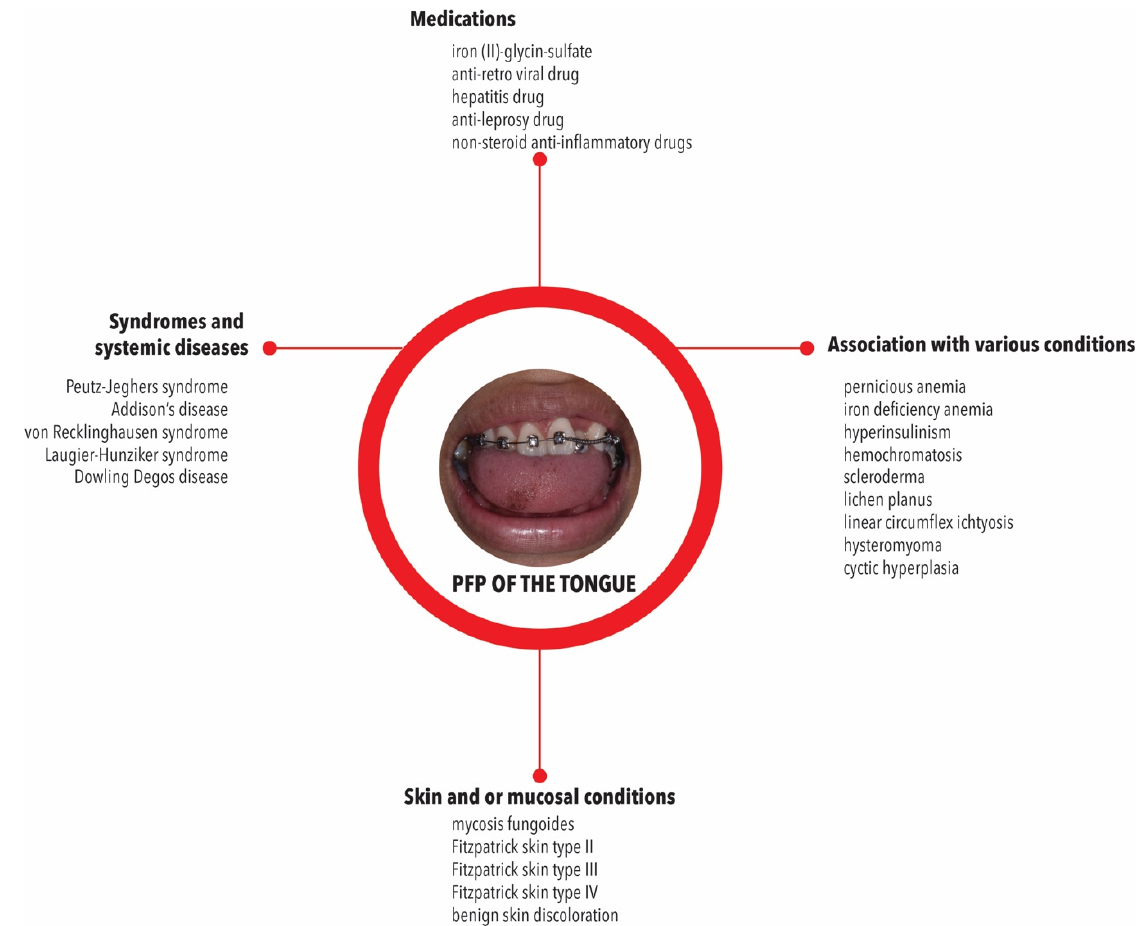
Figure 3. Associations described for PFP with syndromes, systemic conditions, medications, and other related conditions.